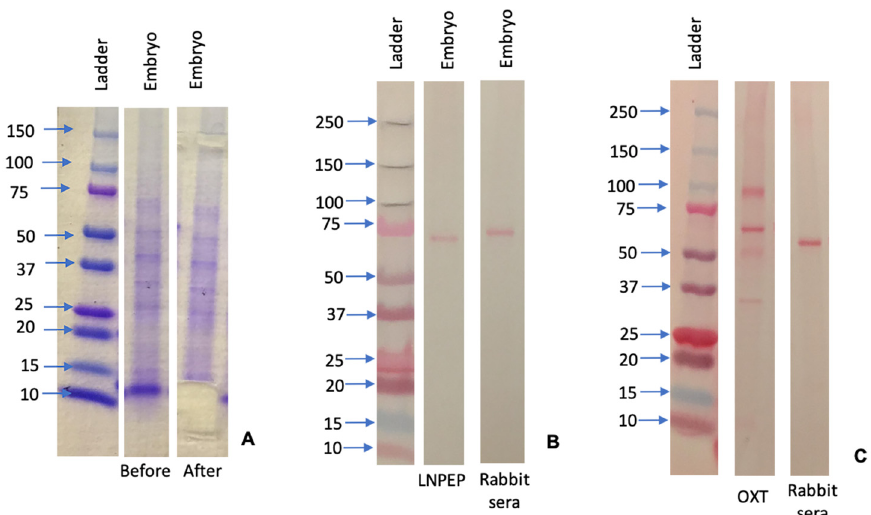
Figure 6. Coomassie blue gel demonstrating before and after band excision ( A ), and western blot gel demonstrating absence of leucyl-cystinyl aminopeptidase (LNPEP) ( B ) and oxytocin (OXT) with a parallel isotope negative control of rabbit sera ( C ).